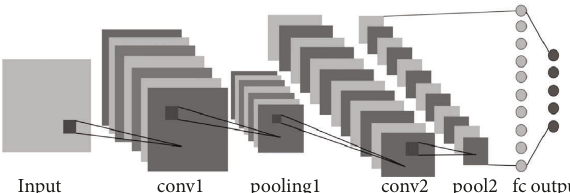
Figure 1: Schematic diagram of convolutional neural network